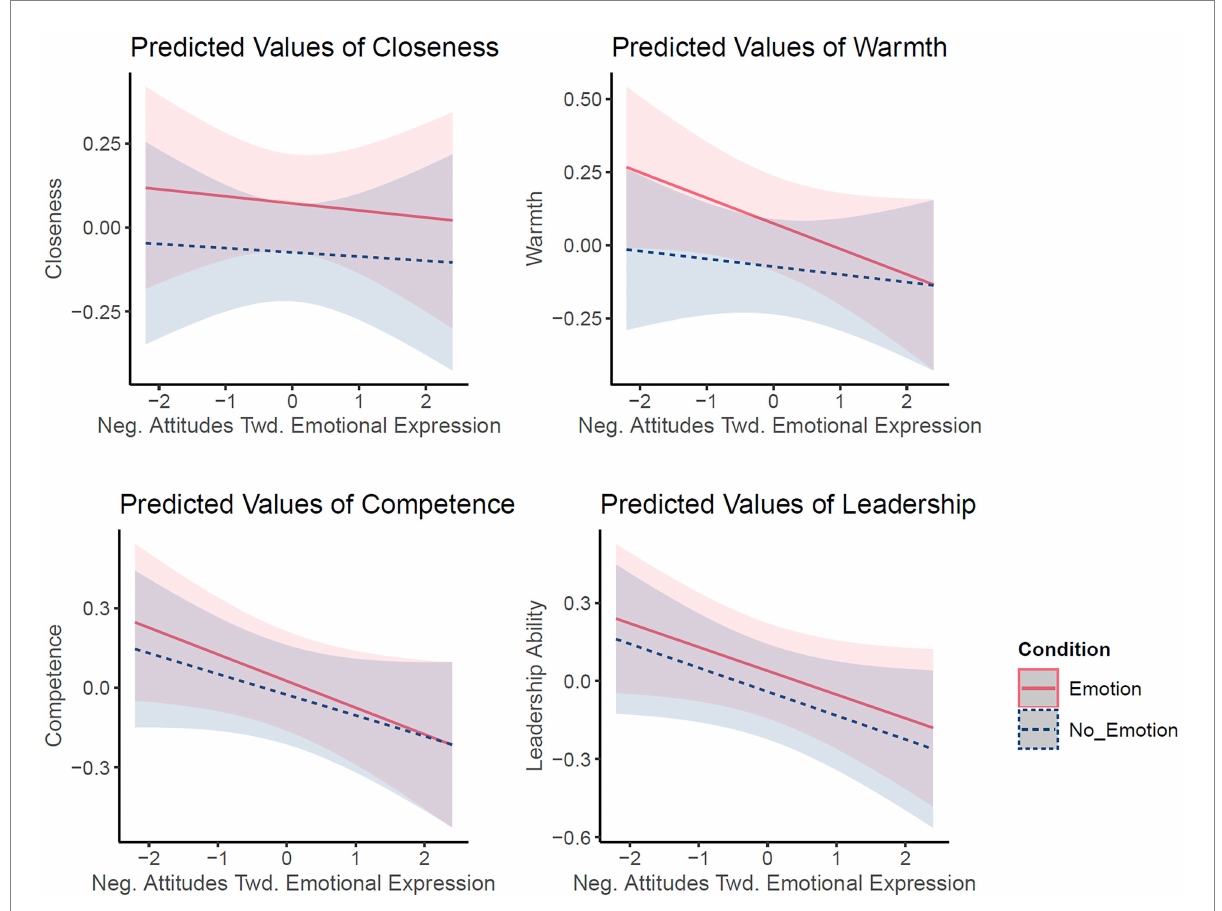
FIGURE 5 Values of All Outcome Variables as Predicted by Negative Attitudes Toward Emotions and Condition (Emotion vs. NoEmotion). Plot was created using the sjPlot package in R based on the reported model. Lines shown depict the predicted values, not data, to visualize the model. The other discrete predictors, not plotted here, were held constant at their proportions (not reference level). All values are